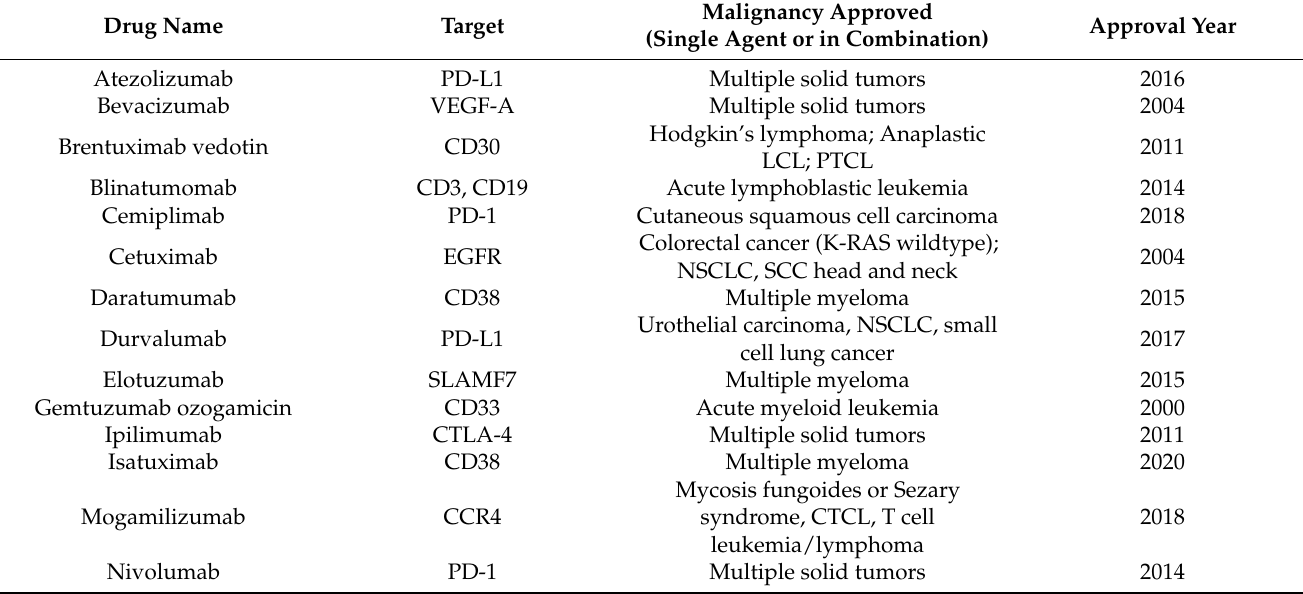
Table 1. Commonly used